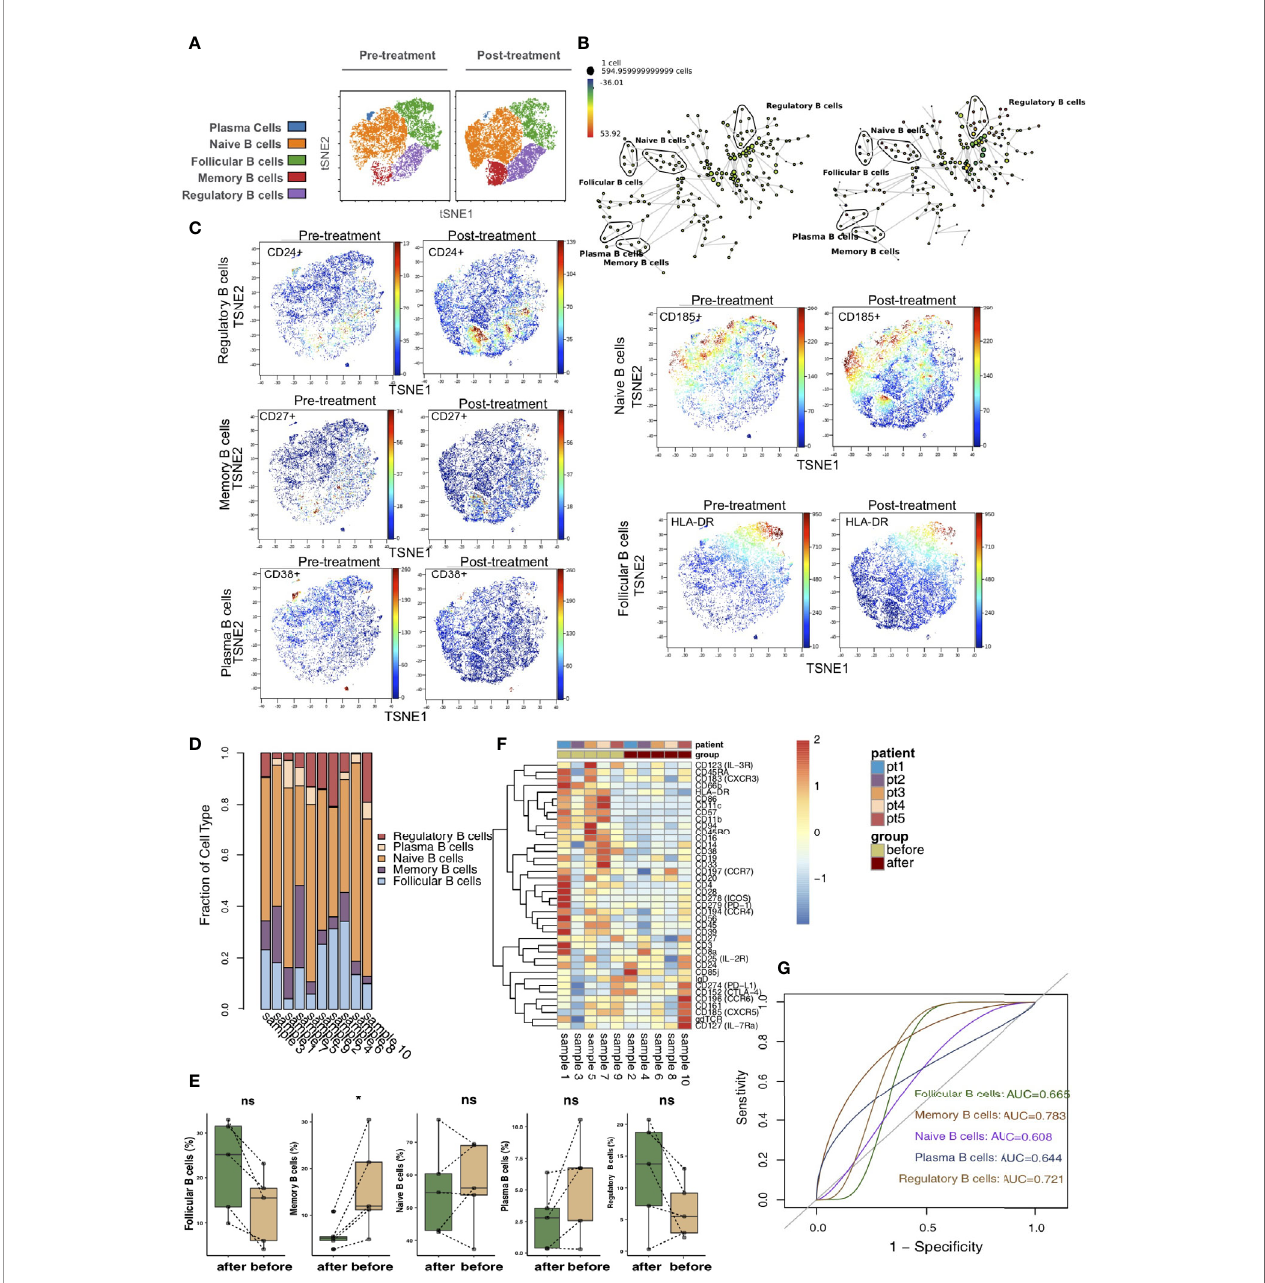
FIGURE 6 | B cells subclusters in the kidney. (A) t-SNE plots of follicular B cells, memory B cells, naive B cells, plasma B cells and regulatory B cells. (B) In SPADE trees, node color is scaled to the fold change in CD185 (CCR5) content, and node size is scaled to the number of cells. (C) t-SNE plots of CD20, CD27, CD185 and CD38 expression in the pre- and posttreatment groups. (D) The proportions of B cell subclusters in all samples. (E) Comparison of the proportion of B cell subclusters between the pre- and posttreatment groups. (F) Heatmap of the marker expression of B cells for all samples. (G) ROC curve of B cell subclusters predicting the pre- and posttreatment groups. *P < 0.05; ns, not signi fi